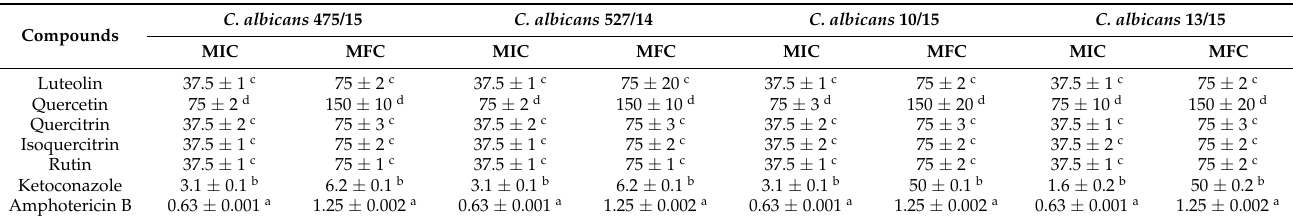
Table 1. Antifungal activity of tested flavonoids, values are means ± SD in µ g/mL of three replicates. Different letters (a, b, c, d) in each column indicate a significant statistical difference between the samples ( p < 0.05). Minimum inhibitory concentration (MIC) and minimum fungicidal concentration (MFC) values of the compounds are compared separately for each of the fungal strain